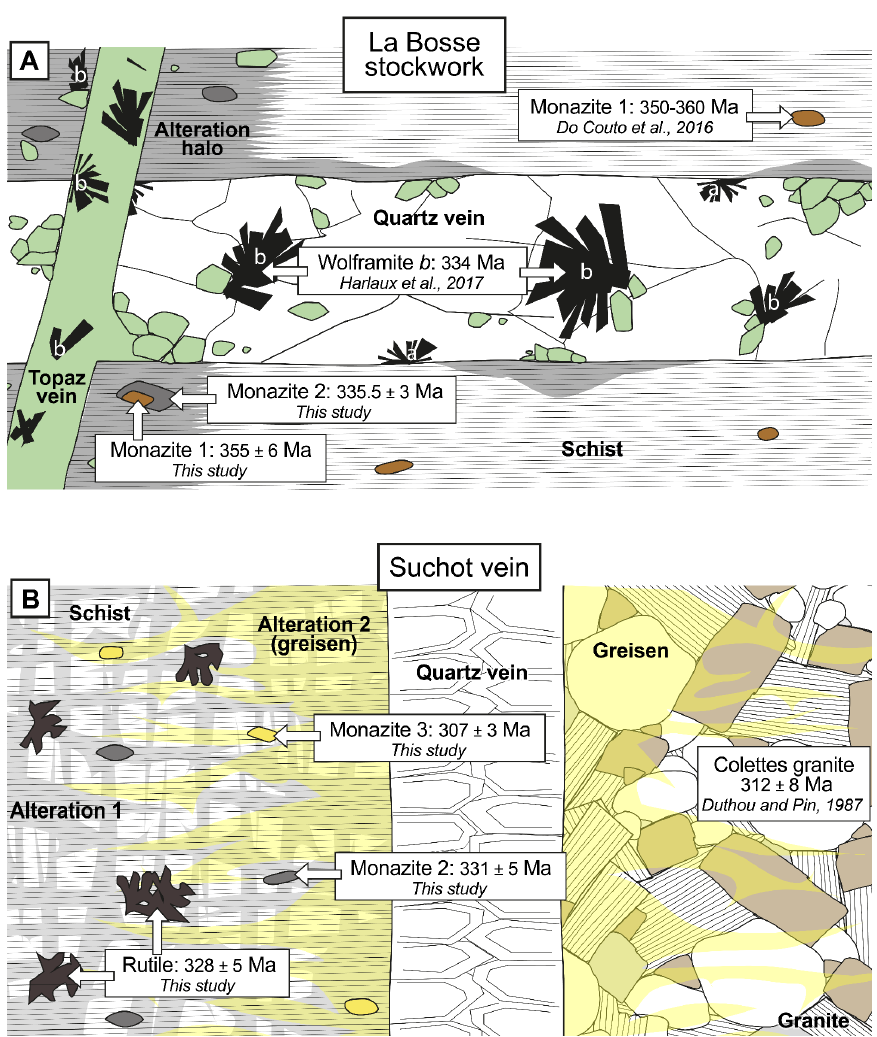
Figure 4. graphical synthesis of alteration relationships and available ages of the studied rocks. (A) La Bosse stockwork: a—wolframite a , b—wolframite b . (B) Suchot